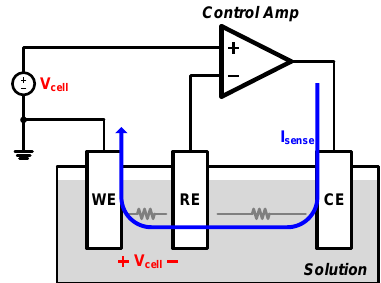
Figure 1. Three-electrode potentiostat sensor.